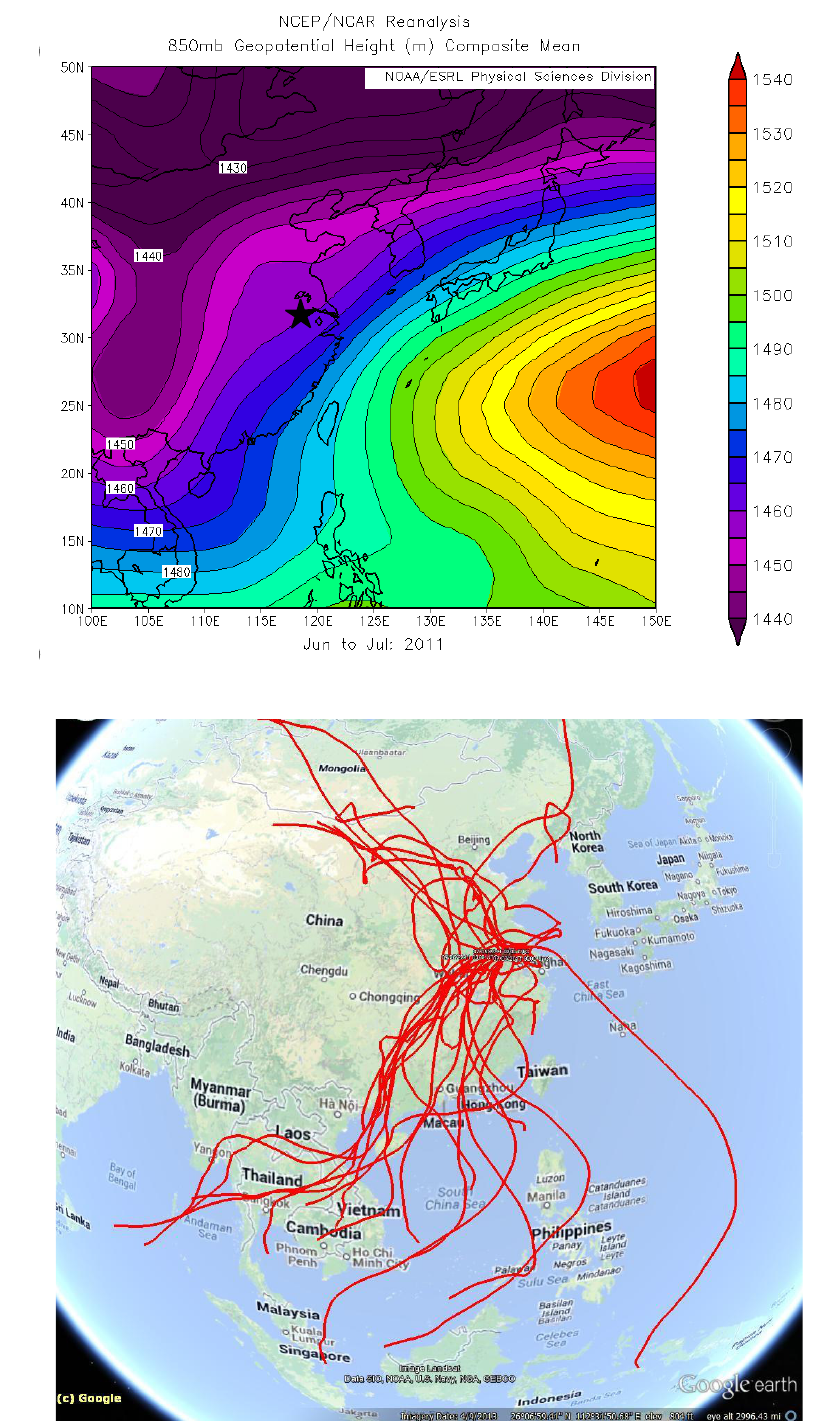
Figure 11. Synoptic-scale flows during the monsoon season ( A ) Geopotential height for June and July, 2011, at the 850 hPa level ( B ) Five-day backward trajectories from Nanjing, China for 7 June 2011 through 7 July 2011 ending at 1500